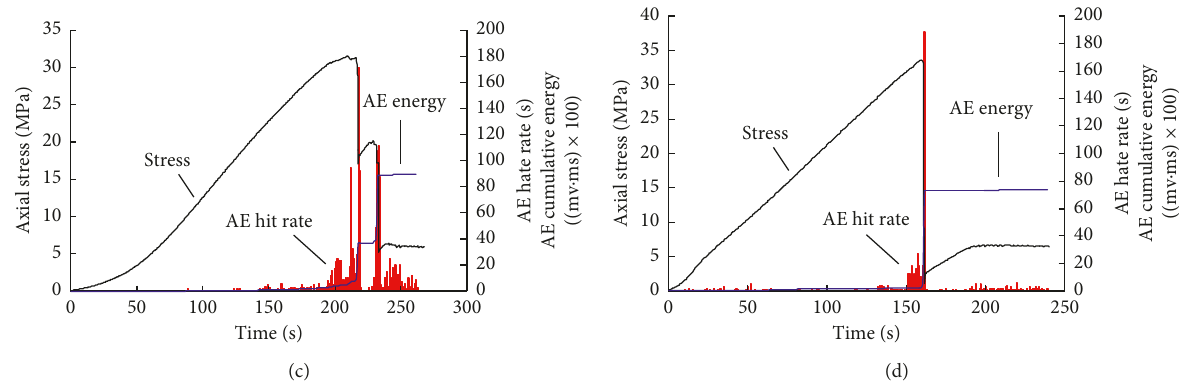
Figure 12: Relation between axial stress, AE hit rate, AE cumulative energy, and time of samples containing a single flaw with different 45 ° ; (c) α 60 ° ; (d) α 75 ° inclinations: (a) α 30 ° ; (b) α (cid:29) (cid:29) (cid:29) (cid:29)